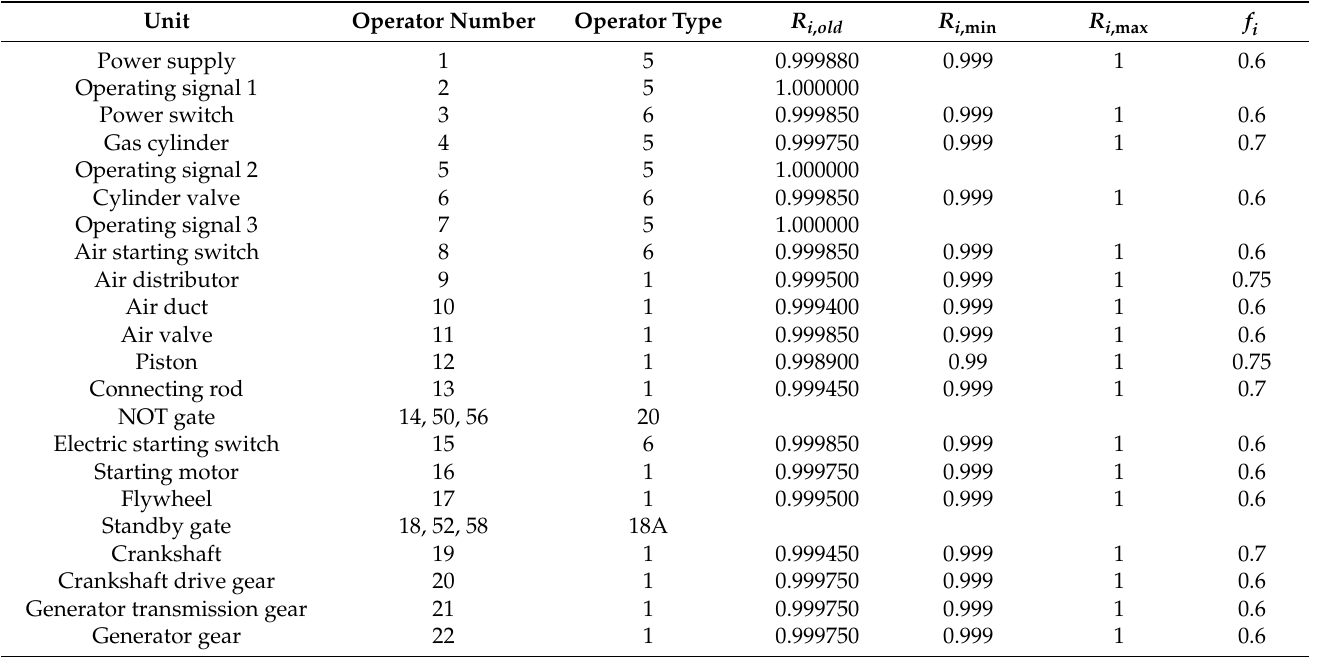
Table 1. Diesel engine system unit operators, reliability data and